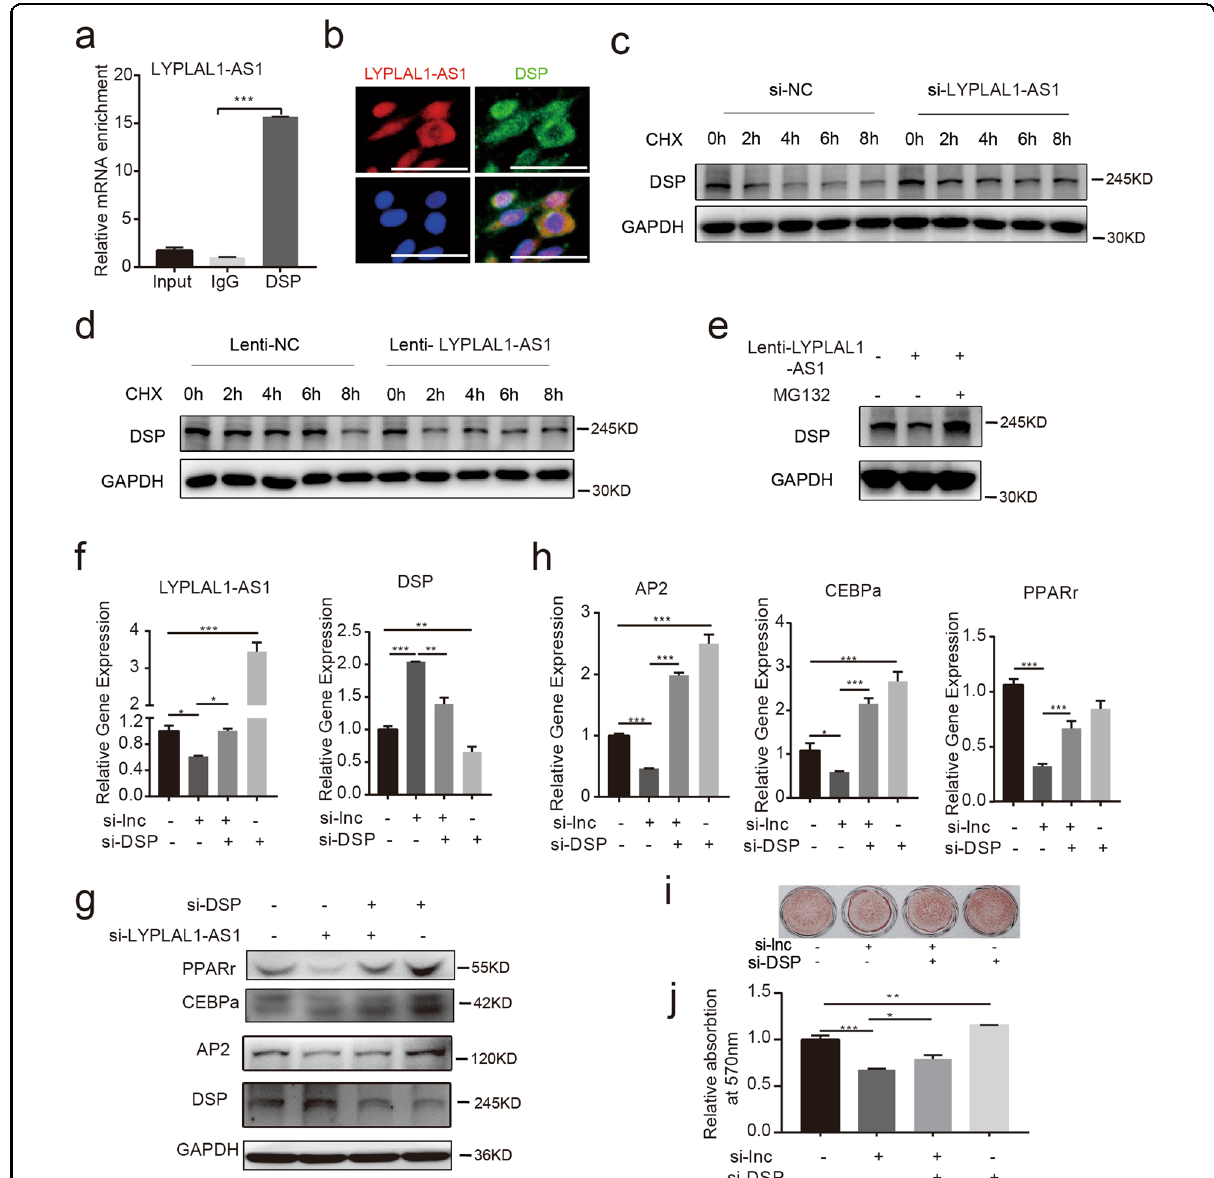
Fig. 6 LYPLAL1-AS1 regulates adipogenic differentiation of hAMSCs potentially by modulating DSP protein stability. a RIP assay to assess the interaction between DSP and LYPLAL1-AS1 in hAMSCs. Antibodies against DSP (DSP) were used to immunoprecipitate lncRNAs, followed by qRT- PCR with LYPLALA-AS1-speci fi c primers. IgG was used as the negative control. Relative abundances were compared to 1% of the input. b FISH assay of LYPLAL1-AS1 transcripts followed by immuno fl uorescence assay for DSP showed the colocalization of LYPLAL1-AS1 transcripts and DSP in the cytoplasm. c , d Western blot analysis of DSP stability in the presence of LYPLAL1-AS1 knockdown ( c ) and LYPLAL1-AS1 overexpression ( d ) in hAMSCs and with treatment with 5 µg/ml cycloheximide (CHX) for 0, 2, 4, 6, and 8 h. e Western blot analysis of DSP in hAMSCs that overexpress LYPLAL1-AS1 and in the absence and presence of MG132 (10 μ M) treatment for 4 h. f LYPLAL1-AS1 knockdown and control hAMSCs were transfected with siRNAs targeting DSP. The levels of LYPLAL1-AS1 and DSP were detected by qRT-PCR. g , h Western blotting ( g ) and qRT-PCR ( h ) assays detected adipogenic marker genes (PPAR γ , AP2, and CEBP α ) in hAMSCs after LYPLAL1-AS1 knockdown, DSP knockdown, and LYPLAL1-AS1 knockdown followed by DSP knockdown. i , j Oil red O staining assay ( i ) and subsequent quanti fi cation ( j ) in hAMSCs after LYPLAL1-AS1 knockdown, DSP knockdown, and LYPLAL1-AS1 knockdown followed by DSP knockdown. GAPDH was used as the internal control for the western blot assays. The quantitative data were normalized to GAPDH, n = 3; data are shown as the mean ± SD; * P < 0.05, ** P < 0.01, *** P < 0.001; scale bars: 50